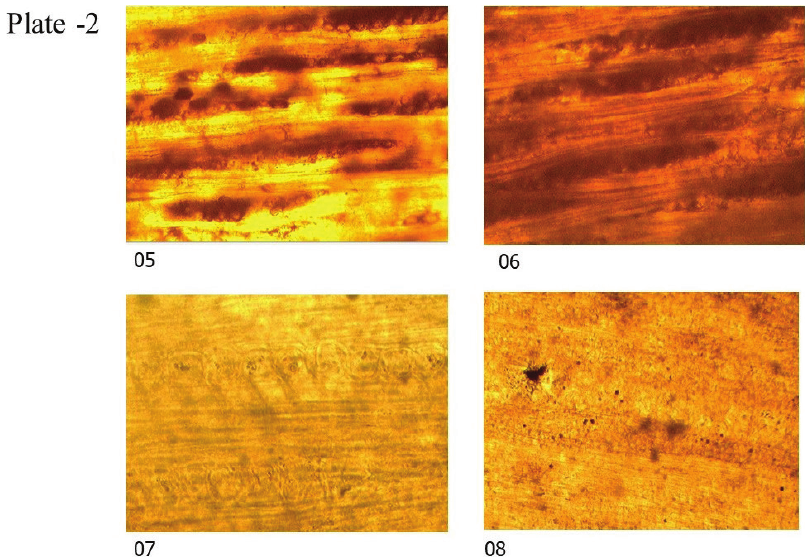
Figure 3. Atalantioxylon thanobolensis sp. nov. Plate 2-05 Tangential section showing general distribution of xylem rays and fibers (×40). Plate 2-06 Tangential section showing general distribution of xylem rays and fibers (×100). Plate 2-07 Tangential section showing details of xylem rays (×400). Plate 2-08 Tangen- tial section showing general distribution of xylem rays and fibers